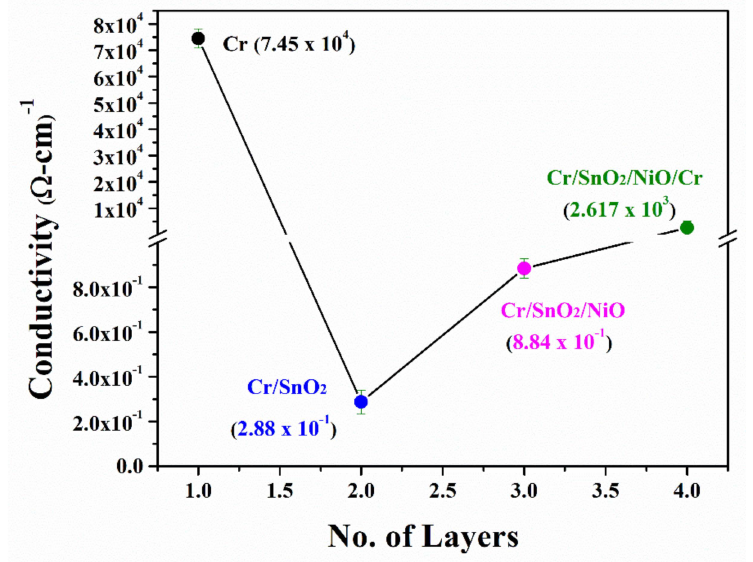
Figure 6. Electrical conductivity of Cr, Cr/SnO 2 , Cr/SnO 2 /NiO, and Cr/SnO 2 /NiO/Cr coatings,